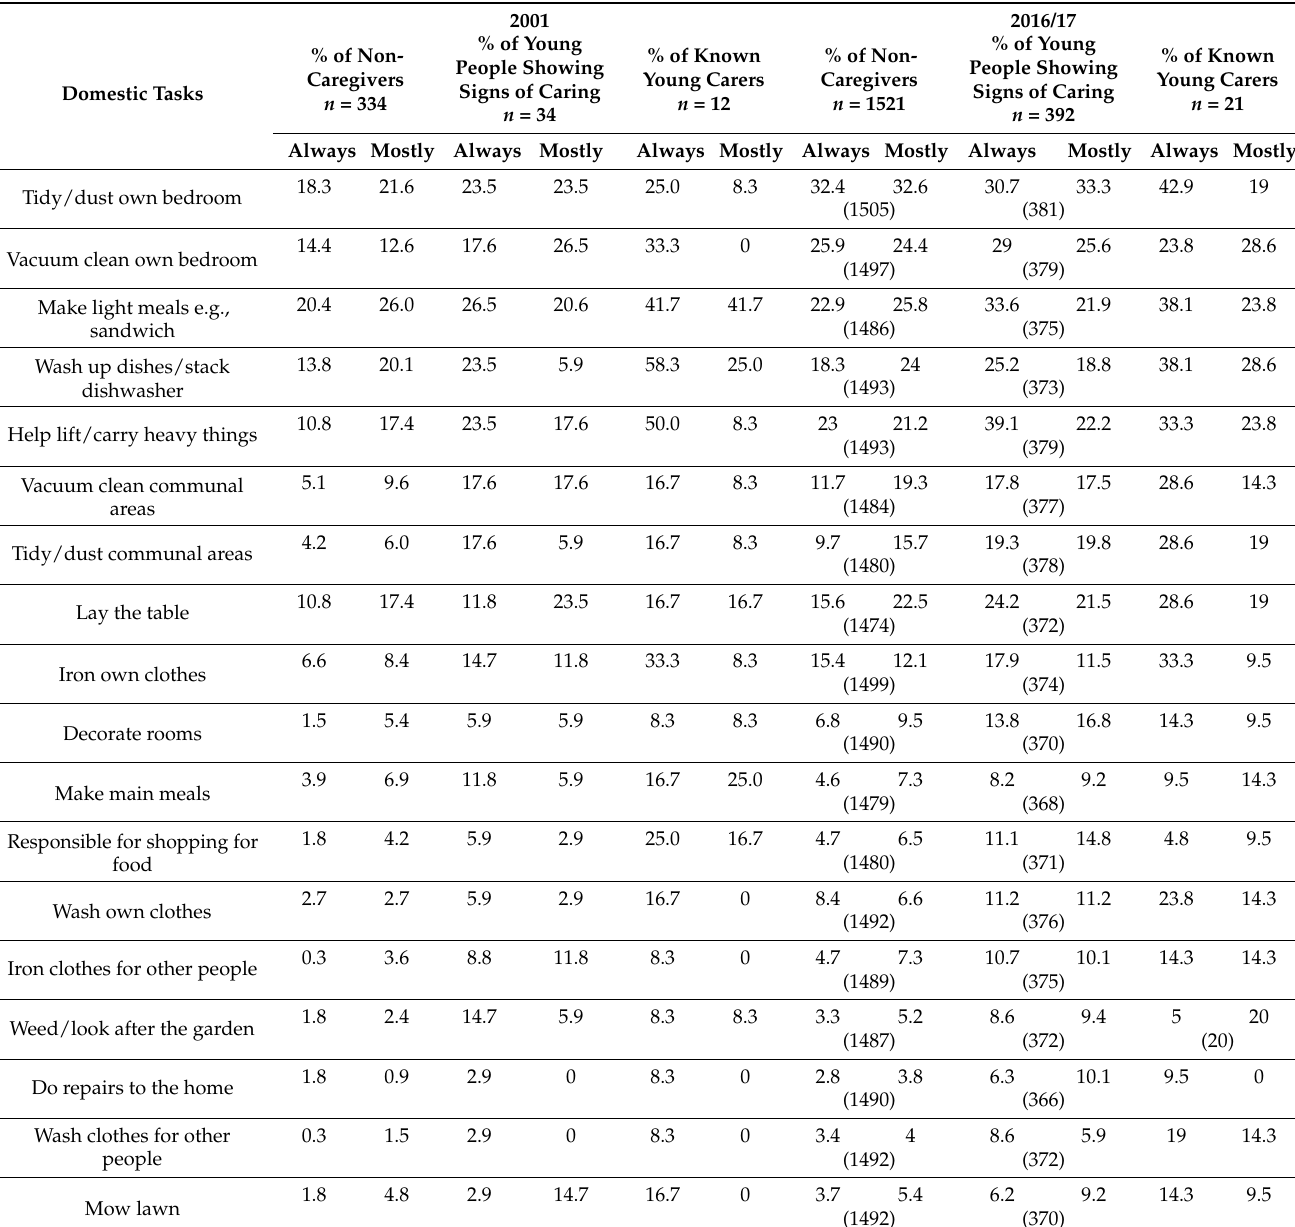
Table 2. Frequency of domestic tasks undertaken by non-caregivers, young people showing signs of caring and known young carers in 2001 and